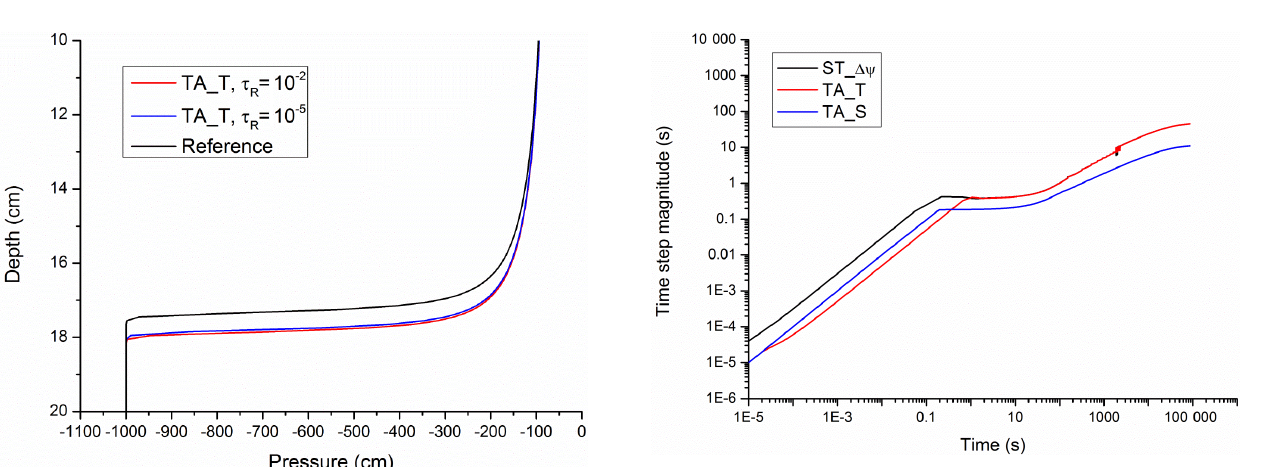
Figure 5. Pressure profiles in the domain for the TA_T algorithm.